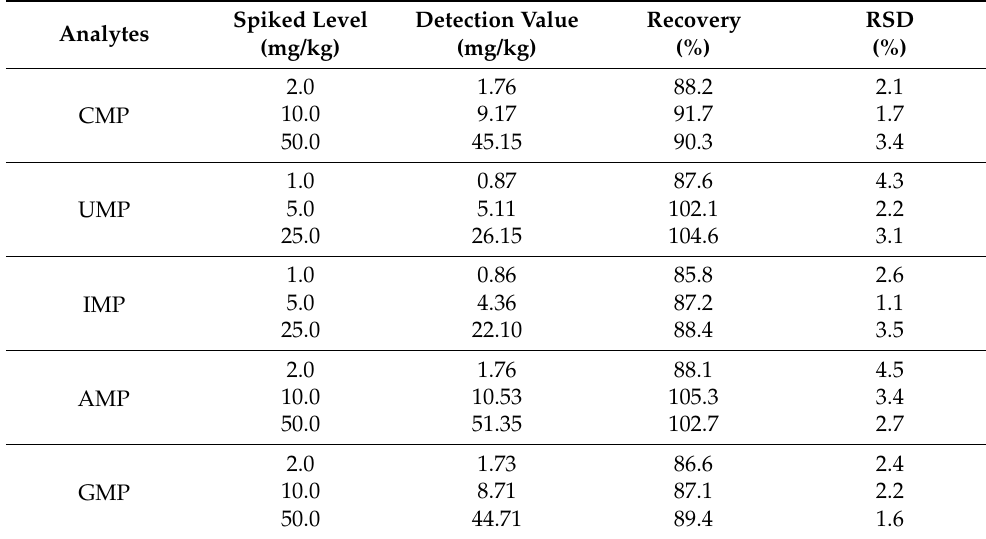
Table 1. Recovery and precision of 5 different nucleotides (n = 6).